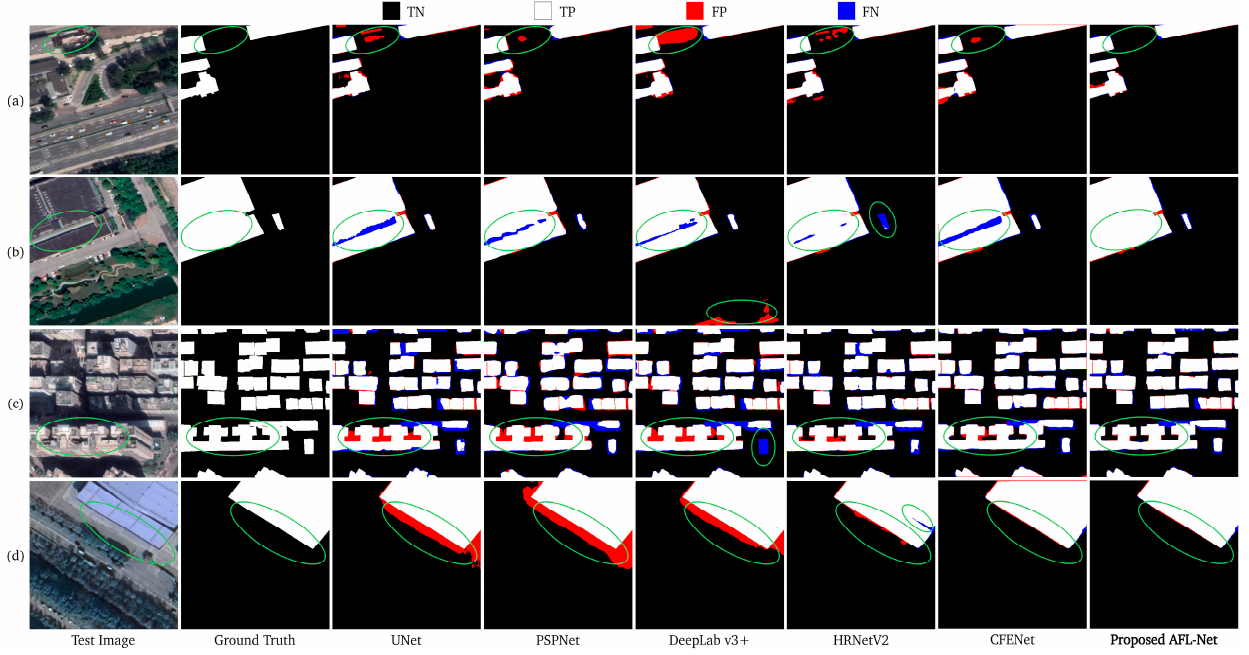
Figure 12. Sample building segmentation results from the selected models with the BITCC dataset (comparative experiment). dataset (comparative